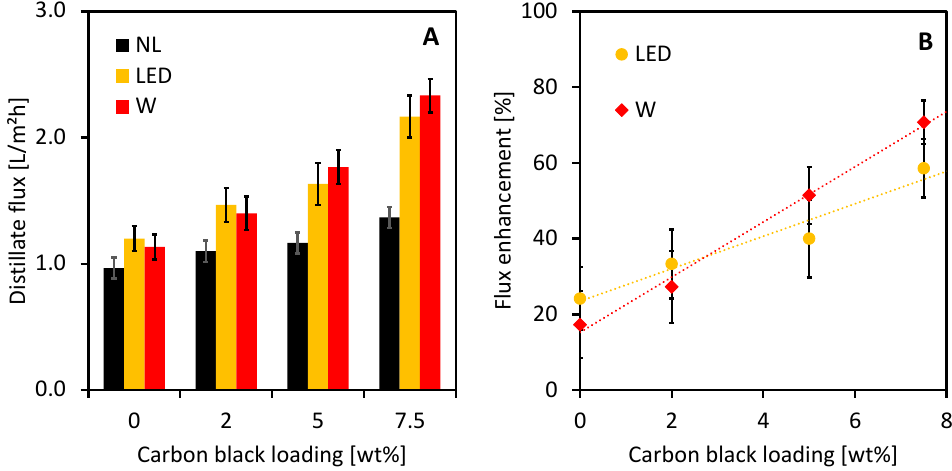
Figure 9. ( A ) mean distillate flux and ( B ) flux enhancement registered during the MD tests with no light (black), LED lamp (yellow) and incandescent light bulb (red).